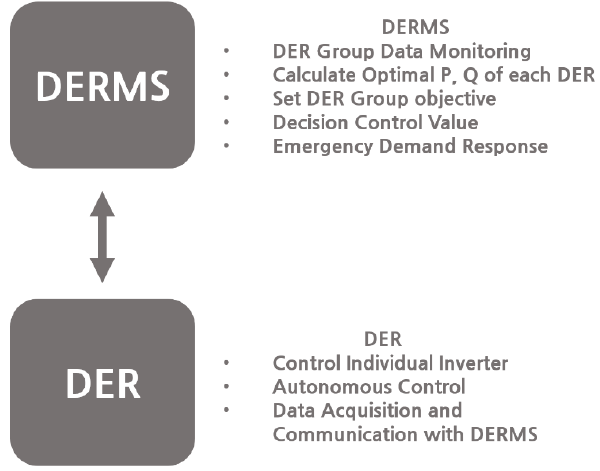
Figure 10. Hierarchical features of DERMS.